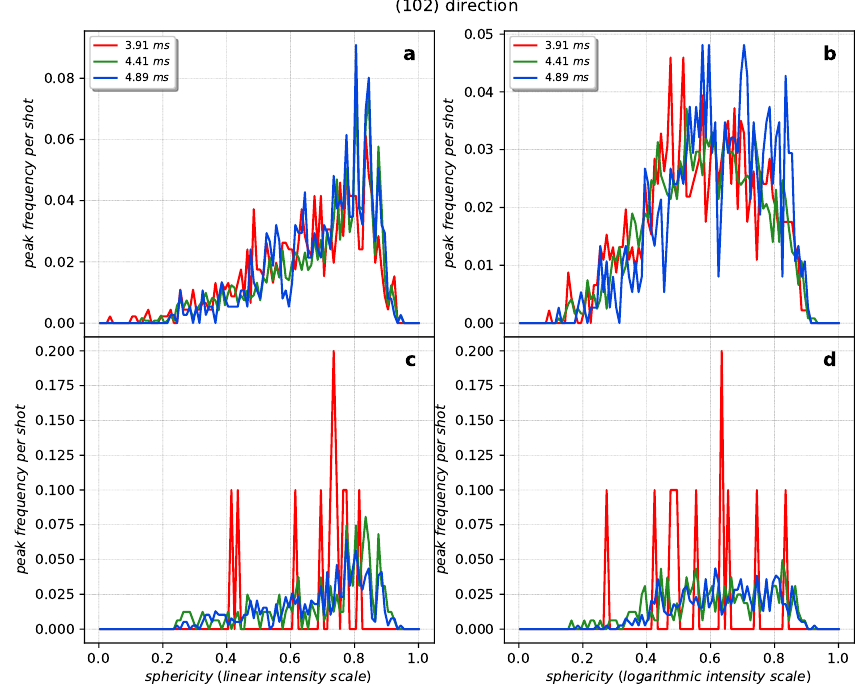
Figure A6. Frequency of a peak appearing with a certain sphericity for the (102) direction for the hits above 50 ADU/pixel ( a ) in linear and ( b ) in logarithmic intensity scales as well as the hits below 50 ADU/pixel ( c ) in linear and ( d ) in logarithmic intensity